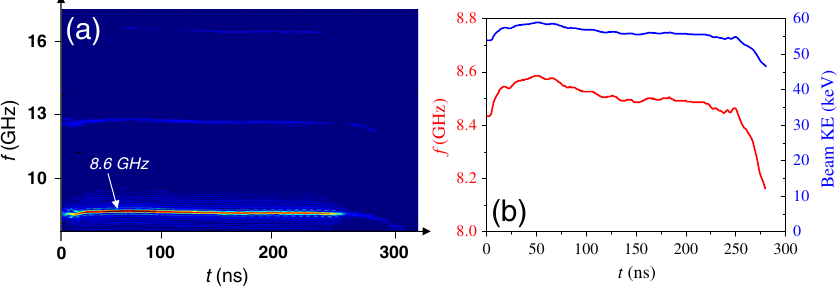
FIG. 3. (Color) (a) Sliding Fourier transform showing time variation of frequency of X-band horn signal. (b) Second harmonic frequency vs time (left-hand scale) and kinetic energy of electrons as deduced from the AB dispersion relation (right-hand scale).